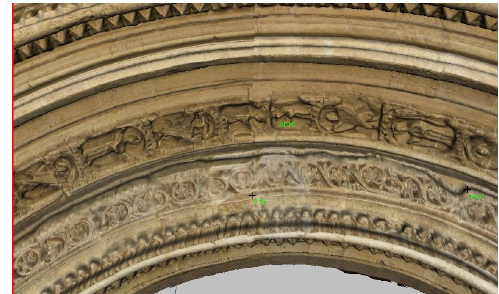
Figure 4: Textured sub-mesh of the arches